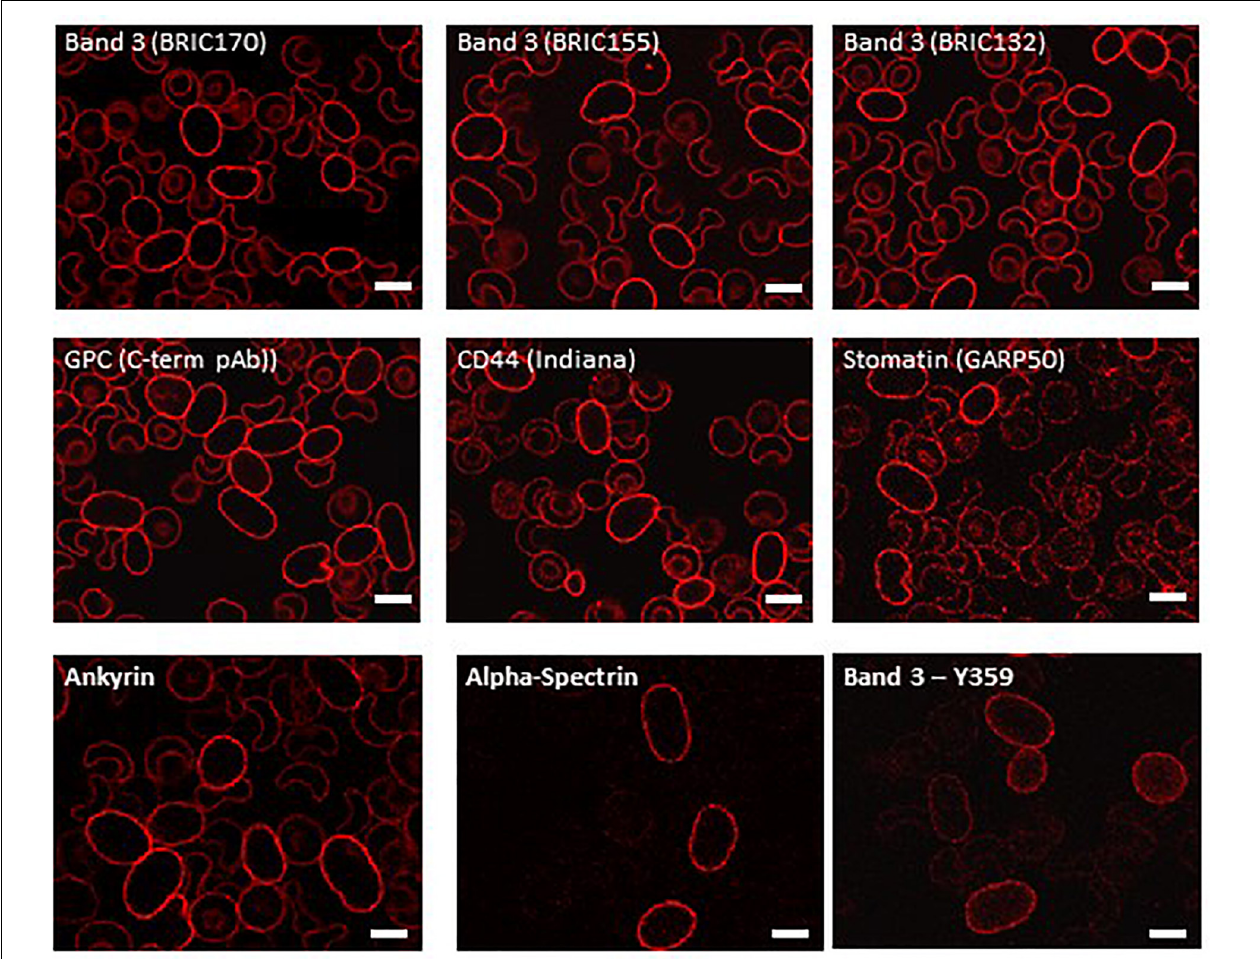
FIGURE 3 | Immunocytochemistry of permeabilized homozygous SAO erythrocytes. Circulating erythrocytes from the homozygous SAO individual were fixed, permeabilized and imaged using immunofluorescent labeling and confocal microscopy. Antibodies directed against intracellular epitopes of plasma membrane proteins. Mouse monoclonal antibodies were used to detect band 3 (BRIC170, BRIC155, BRIC132), stomatin (GARP50), ankyrin (BRIC274) and alpha-spectrin (BRIC174). In-house rabbit polyclonal antibodies were used to detect GPC, CD44 and phospho-Tyr359 band 3. Scale bars represent 5 µ